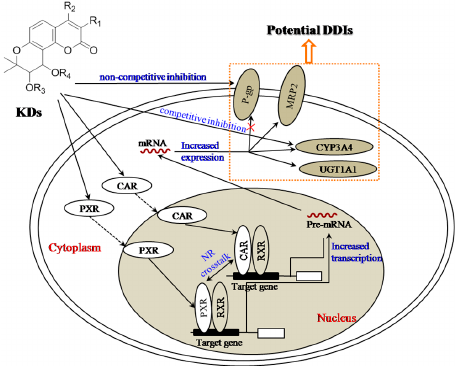
Figure 8. Schematic illustration of activation mechanisms of the potential drug-drug interactions (DDIs) initiated by KDs via CAR- and PXR-mediated pathways.